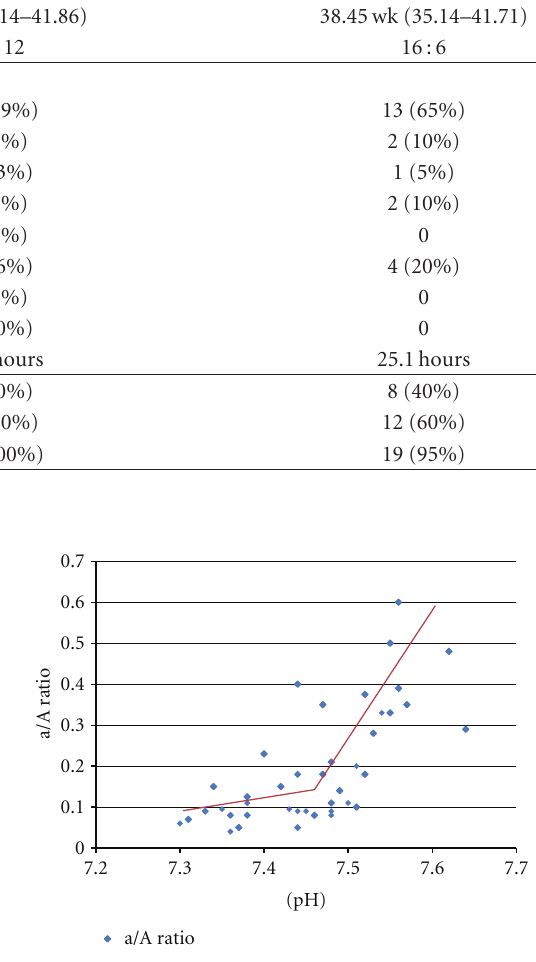
Figure 2: An extreme example of a threshold response of a/A ratio to arterial pH in an individual patient. Correlation coe ffi cient = 0.614, P < 0 . 01. In this instance simple linear regression is not the optimal statistical approach, as the relationship is clearly not